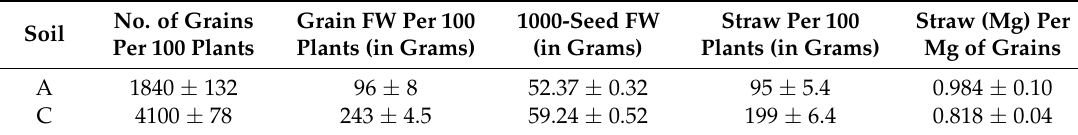
Table 2. Production of grains and straw by wheat cv. JB Asano grown on the metalliferous (A) and the non-contaminated (C) soil. Gravimetric values are given in fresh weight (FW) ± SD (rest water around 16% per